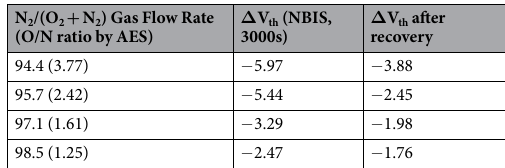
N 2 /(O 2 + N 2 ) Gas Flow Rate (O/N ratio by AES)